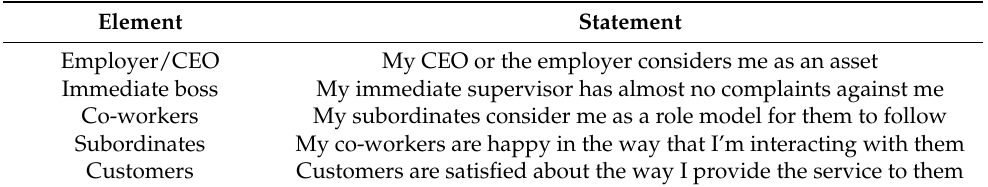
Table 1. The elements and statements of the dimension of “employer’s expectation”.